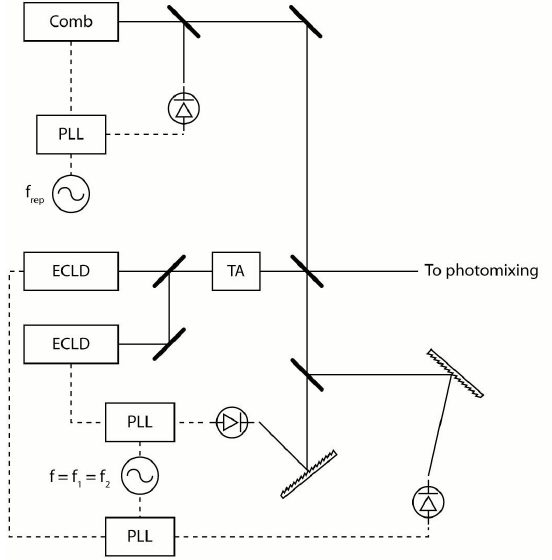
Figure 4. The frequency comb is mixed with the two-color beam each of the ECDLs are phase locked to the nearest mode of the frequency comb synthesizing the difference frequency between the ECDLs with an accuracy of 10 –8 .